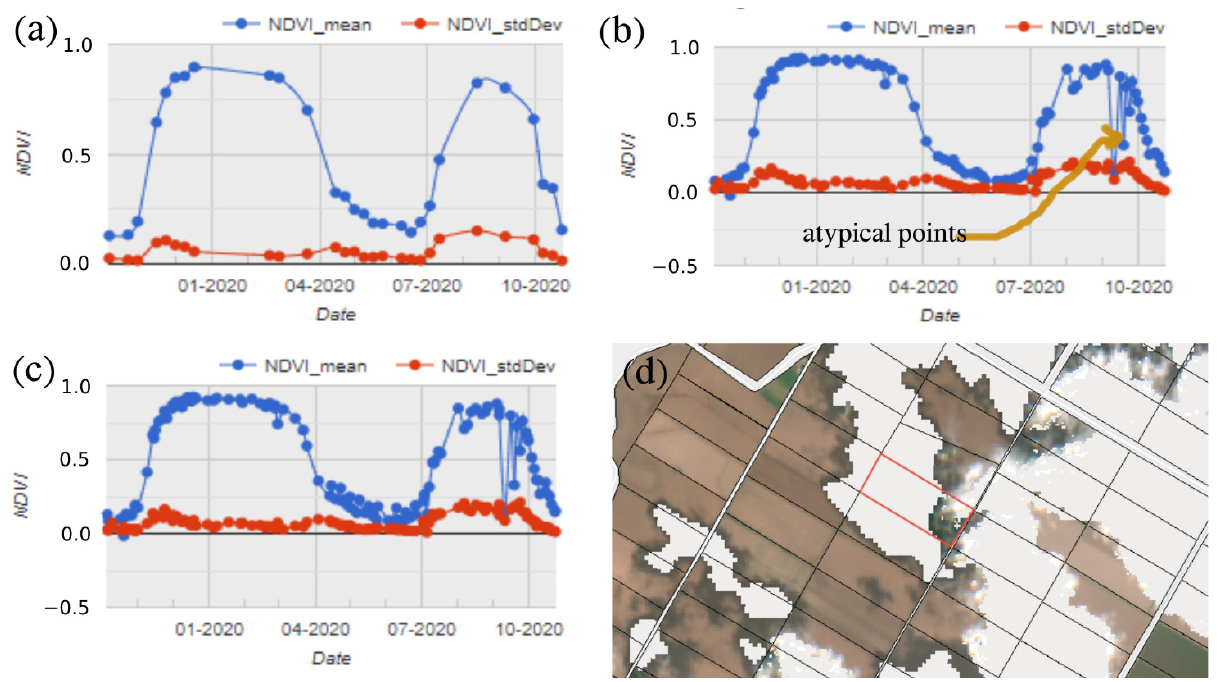
Figure 6. VI time series of different satellite information obtained in VICAL for an agricultural parcel in the north of Sinaloa, Mexico (5 October 2019 to 20 October 2020): ( a ) Landsat-7 and Landsat-8; ( b ) Sentinel-2; ( c ) Landsat-7, Landsat-8, and Sentinel-2; ( d ) RGB composition for the date of an outlier (18 September 2020). The time series ( a – c ) is from the polygon with a red border ( d ).